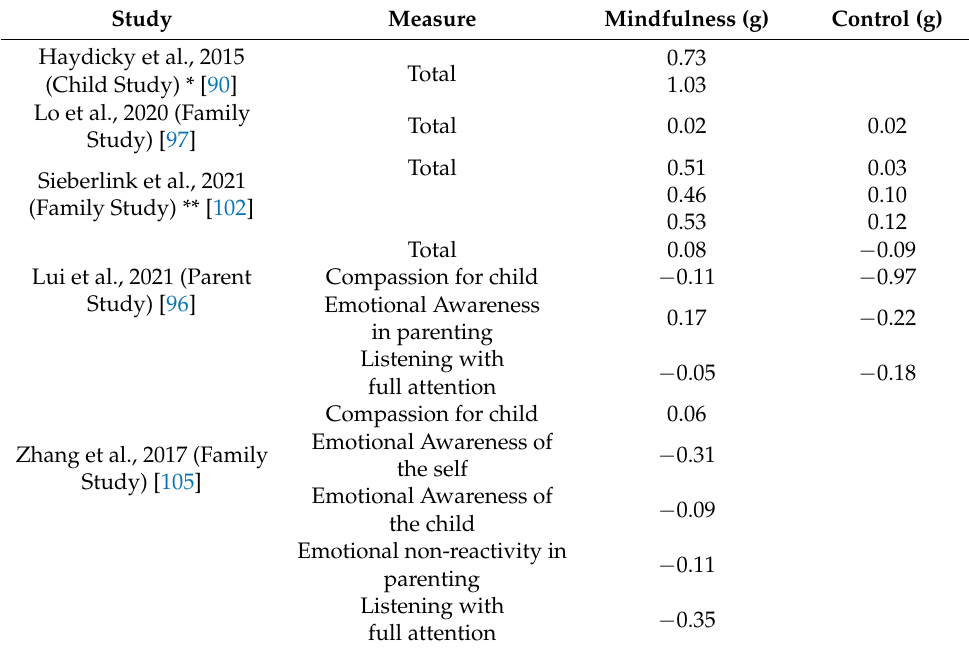
Table 11. Effect sizes for measures of mindfulness in parenting